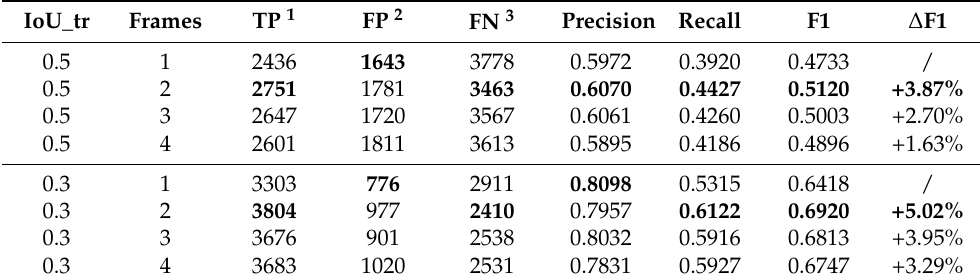
Table 7. Experimental results of using a different number of